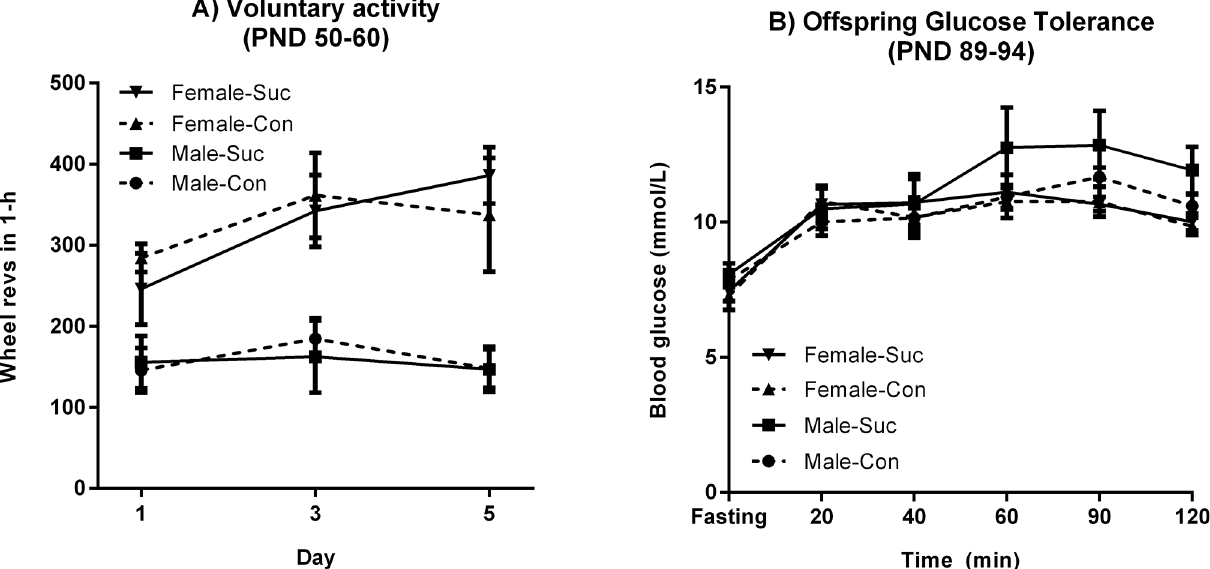
Fig 5. Results from Stage 2. Panel A: Voluntary activity increased over sessions in females but not in males, and there was no effect of maternal sucrose consumption. Panel B: Blood glucose levels rose more rapidly in males than in females in an OGTT, but maternal sucrose exposure had no effect.